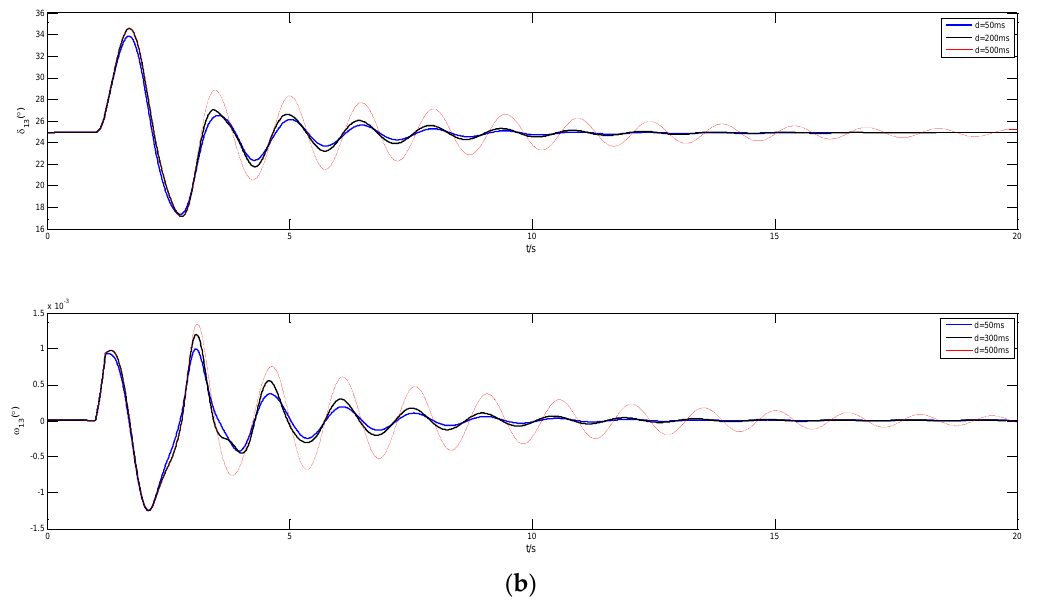
Figure 4. ( a ). The trajectories under different packet loss rate ρ , ( b ). The trajectories under different time delay with ρ = Figure 4 . ( a ). The trajectories under different packet loss rate 𝜌 , ( b ). The trajectories under different time delay with 𝜌 = 0.1 .